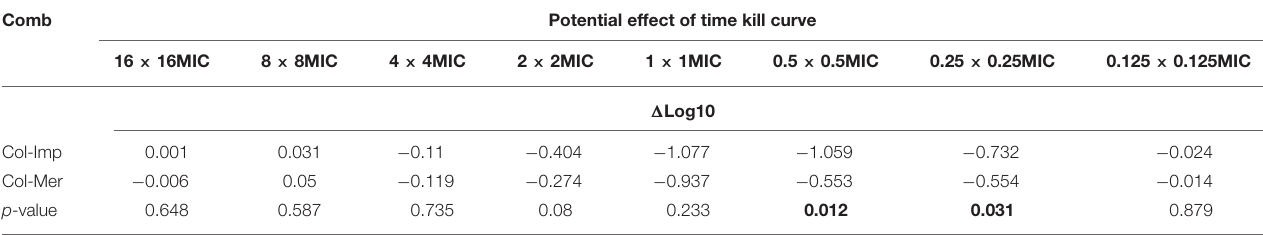
TABLE 5 | Synergistic effect of the combination of antimicrobial agents against Acinetobacter isolates. Comb Potential effect of time kill